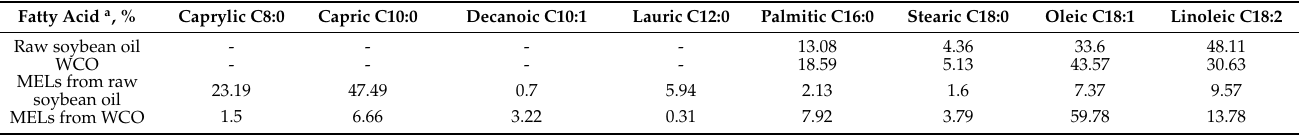
Table 3. MELs produced from raw or waste soybean oil. Adapted from